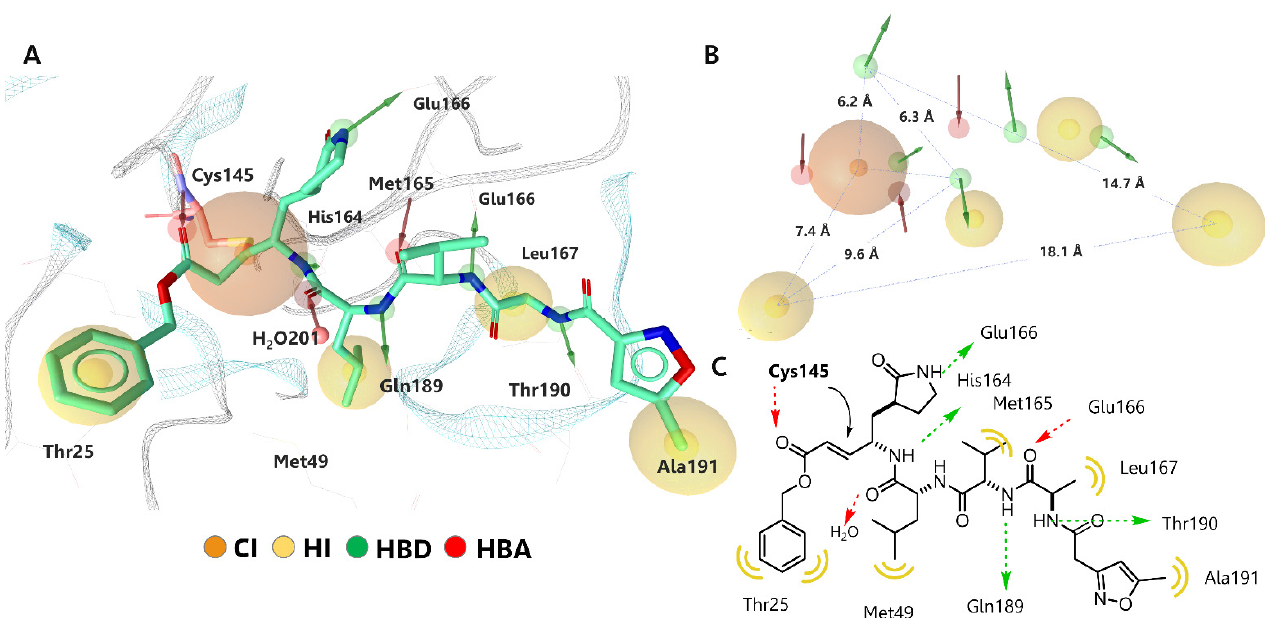
Figure 3. Structure-based pharmacophoric modeling of SARS-CoV-2 M pro in complex with N3. ( A ) Representation of the pharmacophoric modeling on the binding site pocket. ( B ) A 13-point pharmacophoric map; key features include HBD (green), HBA (red), H (yellow), CI (orange), and distance relation in Å. ( C ) Two-dimensional representation of the interactions that determine the binding of the inhibitor N3 on SARS-CoV-2 M pro .